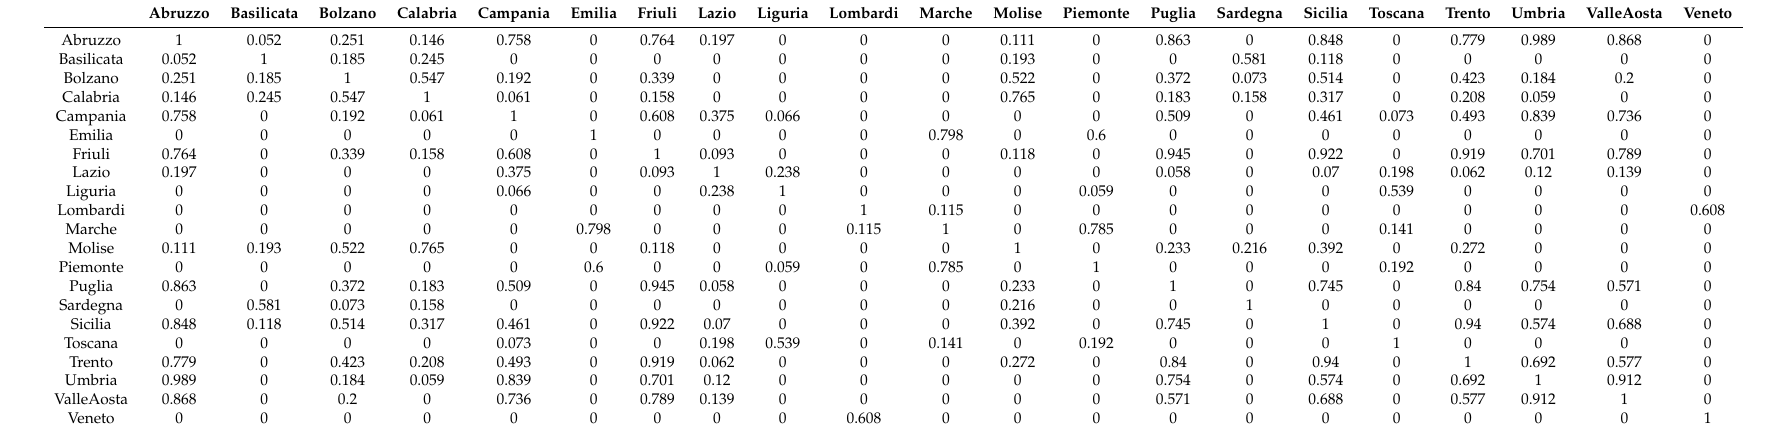
Table A7. Similarity values of Intensive Care network in the study period.